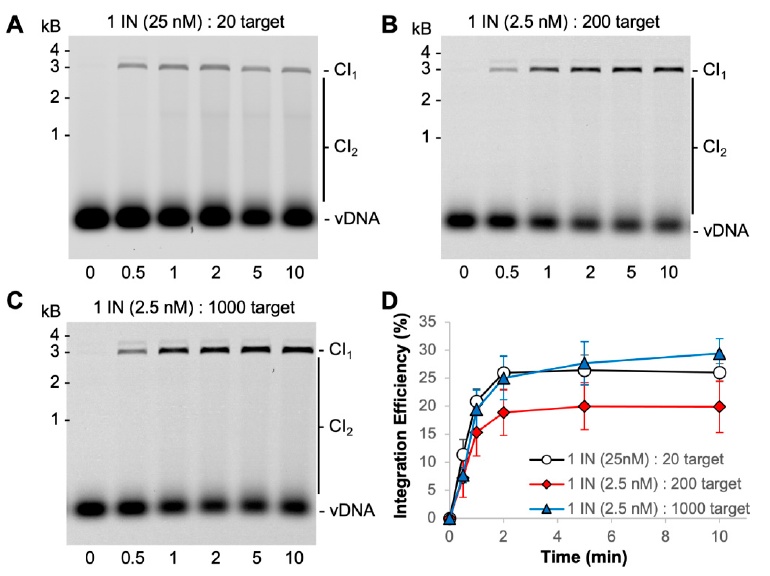
Figure 4. Increasing the molar ratio of target to PFV intasomes. ( A ) Typical reaction conditions with 25 nM PFV intasomes are 20-fold molar excess of target sites to intasomes; ( B ) reducing the intasome concentration to 2.5 nM increases the molar excess of target sites to 200-fold; ( C ) increasing the target DNA concentration allowed for 1000-fold molar excess of target sites to 2.5 nM intasomes. Cy5 images of agarose gels show the accumulation of CI 1 and CI 2 products over time. ( D ) The total Cy5 fluorescence in each lane was quantified and each integration product calculated as the fraction of the total fluorescence. The average of three independent experiments with at least two independent intasomes preparations is shown. Error bars indicate the standard deviation.